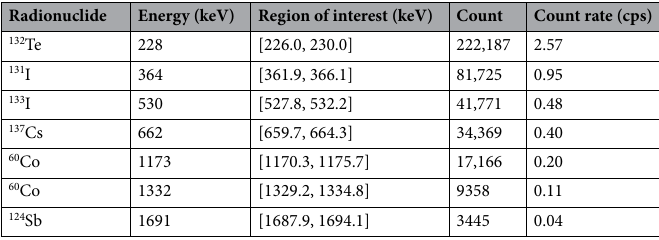
Nuclide (energy/keV)